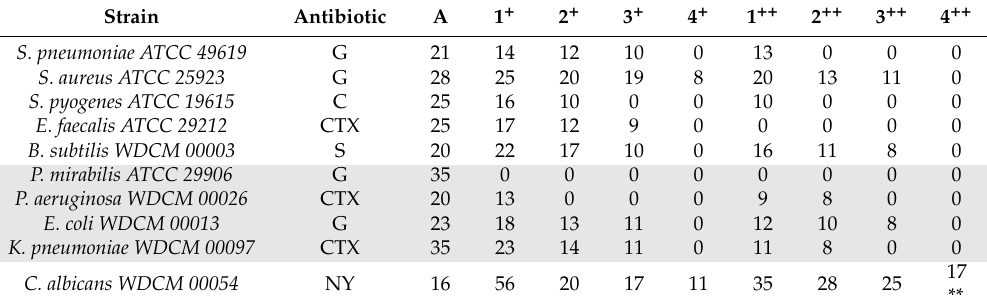
Table 1. Antimicrobial testing of antibiotics (A), AV-PVP-I 2 ( + ), AV-PVP-I 2 -NaI ( ++ ), and dilutions. ZOI (mm) against microbial strains by disc di ff usion assay as dilution